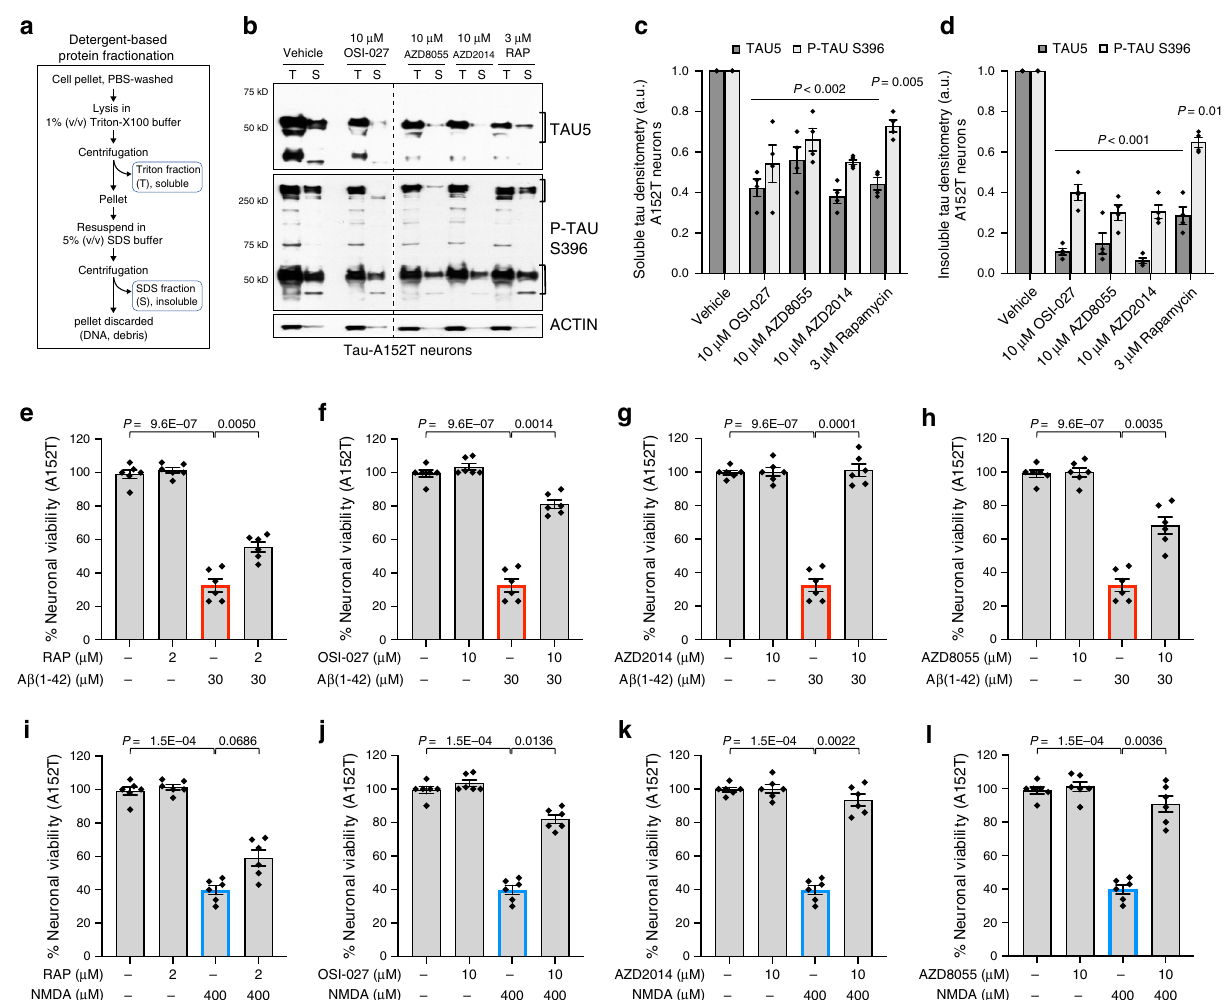
Fig. 3 Rescue of tau phenotypes in 8-week differentiated A152T (FTD19-L5-RC6) neurons upon 24 h treatment. a Summary of the assay for protein fractionation based on Triton-X (T) and SDS (S) detergents differential solubility. b – d Western blot analysis of tau after mTORi compound treatment and detergent fractionation. b Samples were run on the same blot, image cropped (dotted line) only for the purpose of this fi gure. Brackets indicate protein bands for densitometry analysis. Graph bars represent mean densitometry ± SEM, and black diamond-dots indicate individual data points for soluble ( c ) and insoluble ( d ) total tau (TAU5) and P-tau S396 levels relative to vehicle samples. n = 4 biological replicates. Statistical signi fi cance relative to vehicle was calculated using two-tailed unpaired t -test and P values are indicated in each graph. e – l Rescue of neuronal vulnerability to 30 μ M A β (1-42) (red) and 400 μ M NMDA (blue), by pre-treatment with rapamycin ( e , i ), OSI-027 ( f, j ), AZD2014 ( g , k ) or AZD8055 ( h , l ). Assay summary in Supplementary Fig. 4f. Bars represent mean % viability relative to vehicle-treated neurons ± SEM, and black diamond-dots represent individual data points for n = 3 biological replicates with 2 technical replicates per experiment. Statistical signi fi cance was calculated with a two-tailed unpaired t -test and P values are indicated ( ns P > 0.05, * P ≤ 0.05, ** P ≤ 0.01, *** P ≤ 0.001, **** P ≤ 0.0001). Source data are provided as a Source Data fi